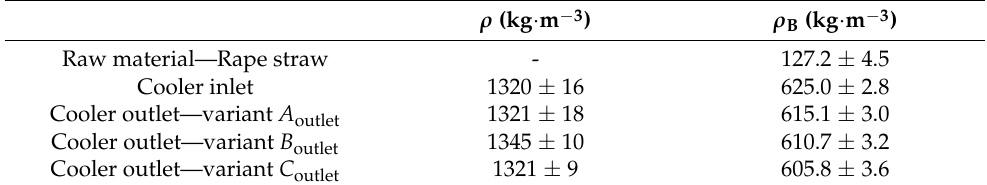
Table 2. Particle and bulk density of raw material and pellets before and after cooling process.